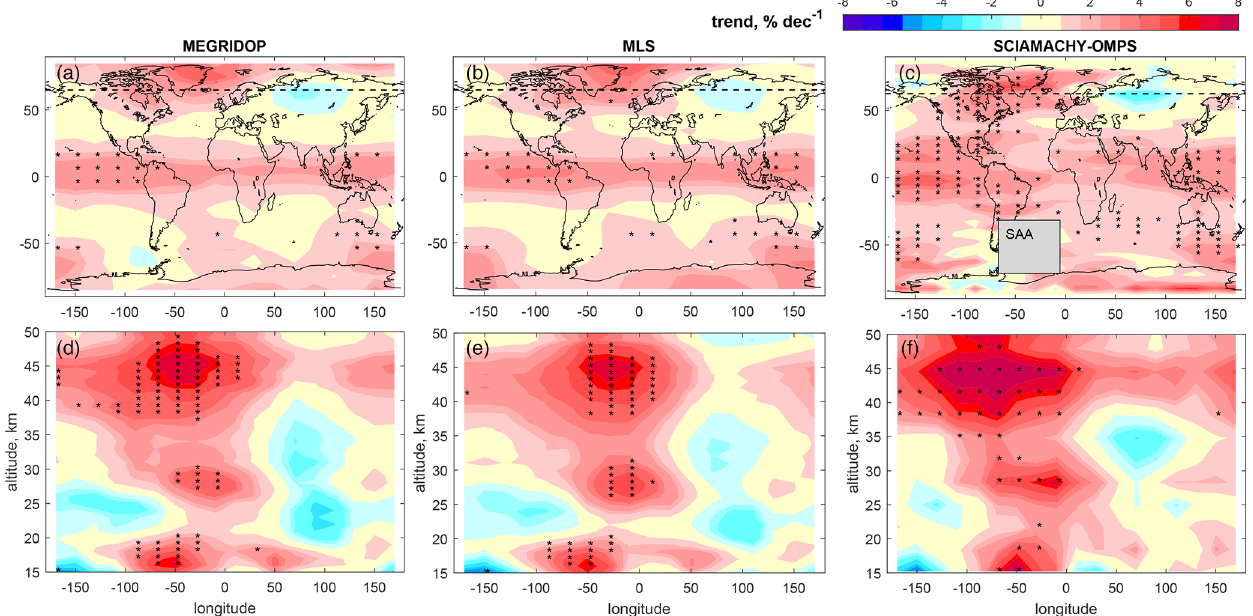
Figure 12. (a, b, c) Ozone trends in late 2004–2018 (%decade − 1 ) at 35km and (d, e, f) longitude–altitude cross section of the ozone trends at ∼ 65 ◦ N (the latitude is indicated by a dashed line on the top panels). Ozone trends are estimated using the MEGRIDOP (a, d) , MLS (b, e) and SCIAMACHY-OMPS datasets (c, f) . For the SCIAMACHY-OMPS dataset, ozone trends in the Southern Atlantic Anomaly (SAA) region are not shown because SCIAMACHY data are flagged in this